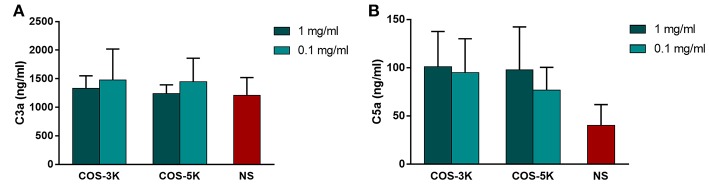
Effects of COS on complement system. (A) Concentration of C3a in serum. (B) Concentration of C5a in serum. NS, normal saline.